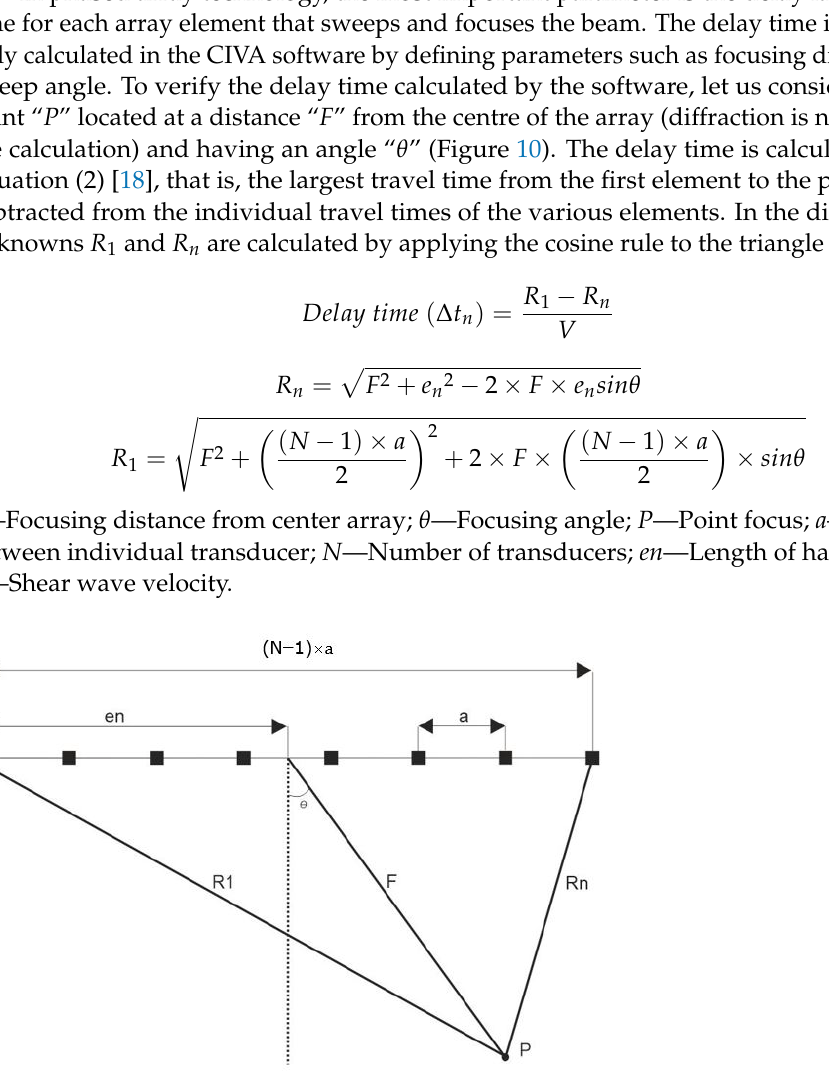
Figure 10. Schematic representation of delay time calculation for point focus.